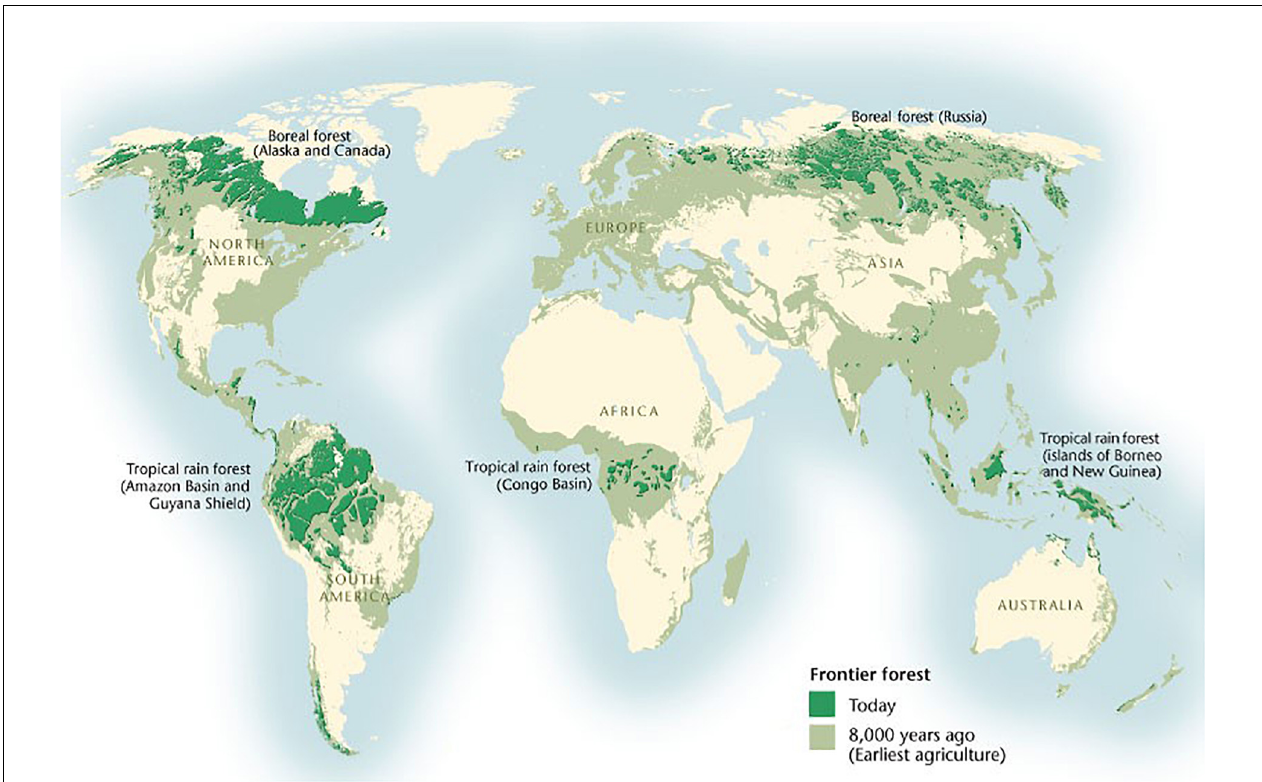
FIGURE 1 | The largest intact forest regions on earth are primarily confined to five regions: the forests of New Guinea and Borneo, the Congo Basin, the Amazon Basin, the Russian Boreal Forest, and the North American Boreal Forest. Map courtesy of Canadian